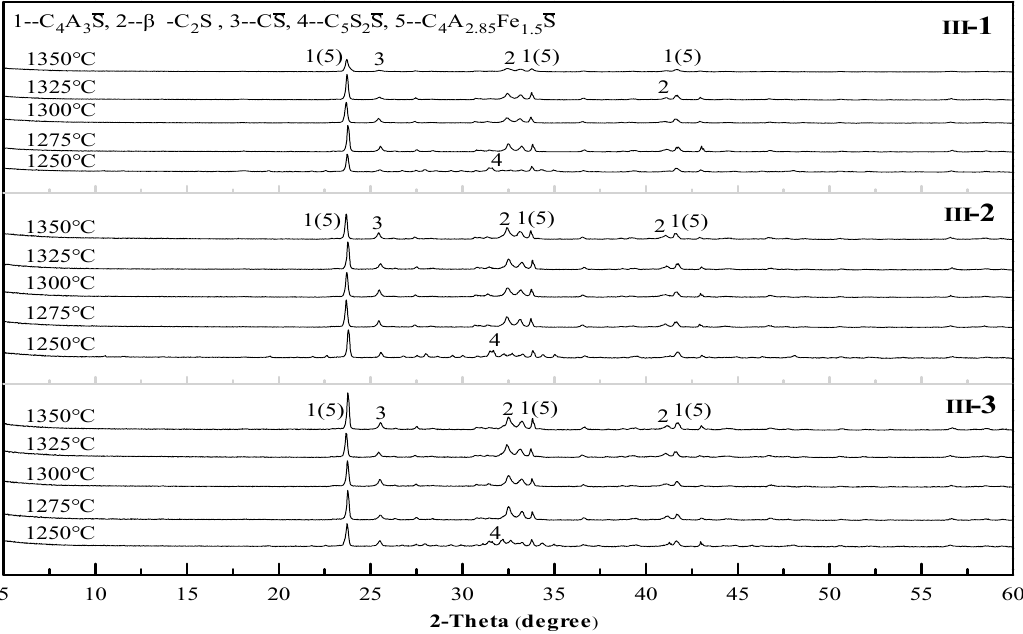
Figure 7. X-ray diffraction (XRD) patterns of the Series III cement clinkers at different temperatures.